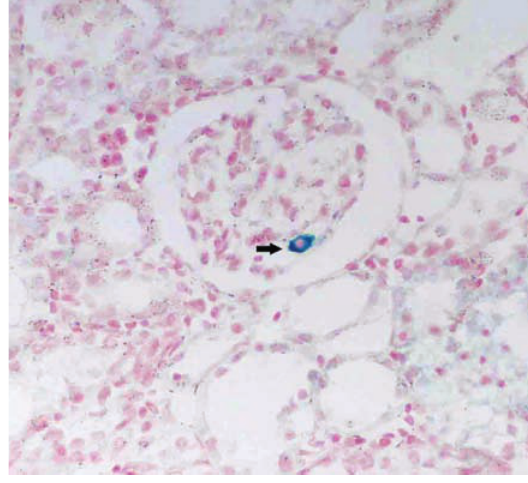
Figure 12 Most cells positive for Prussian blue staining (arrow) are located in the glomeruli in outer zone of renal cortex in the kidneys of group A (transplanted with labelled cells), which corresponds to the signal intensity loss observed in MR image. (Prussian blue staining,